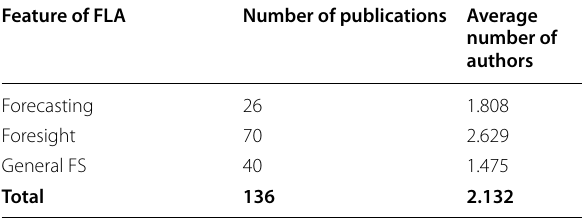
Table 3 Distribution of articles by their features of FLA Feature of